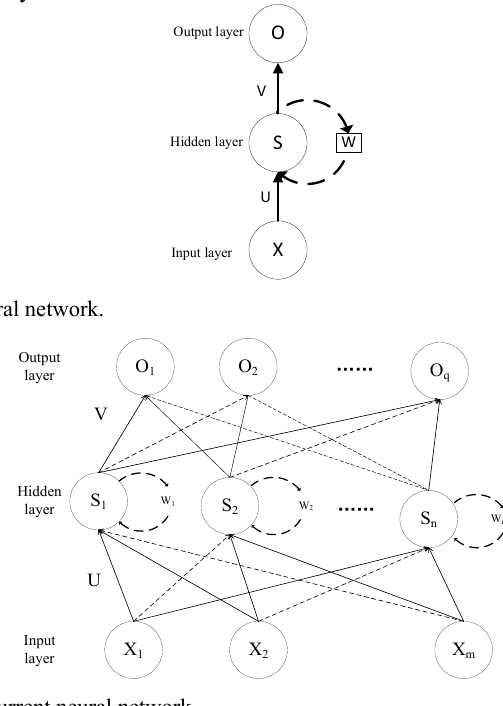
Fig. 2. Multilayer recurrent neural